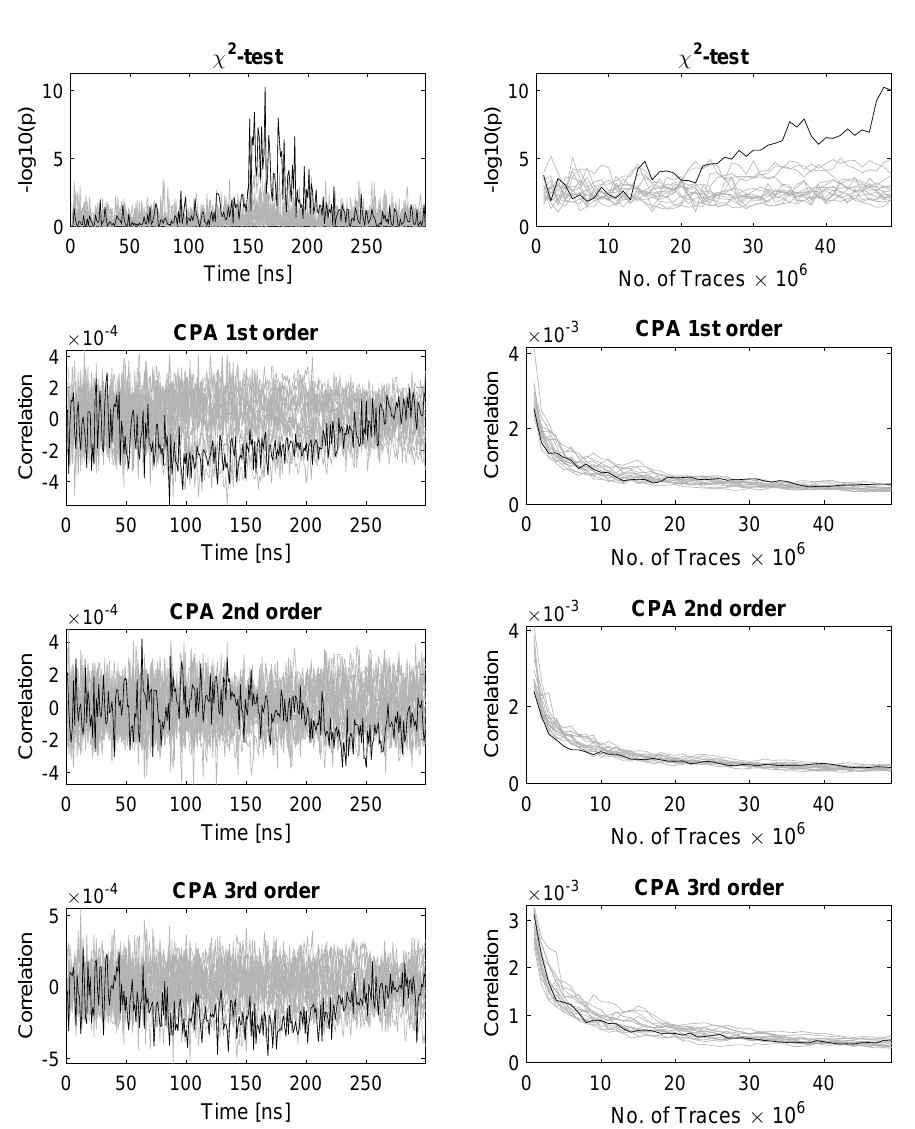
Figure 10: Results of the attack using χ 2 -test as a distinguisher and the corresponding 1st- to 3rd-order